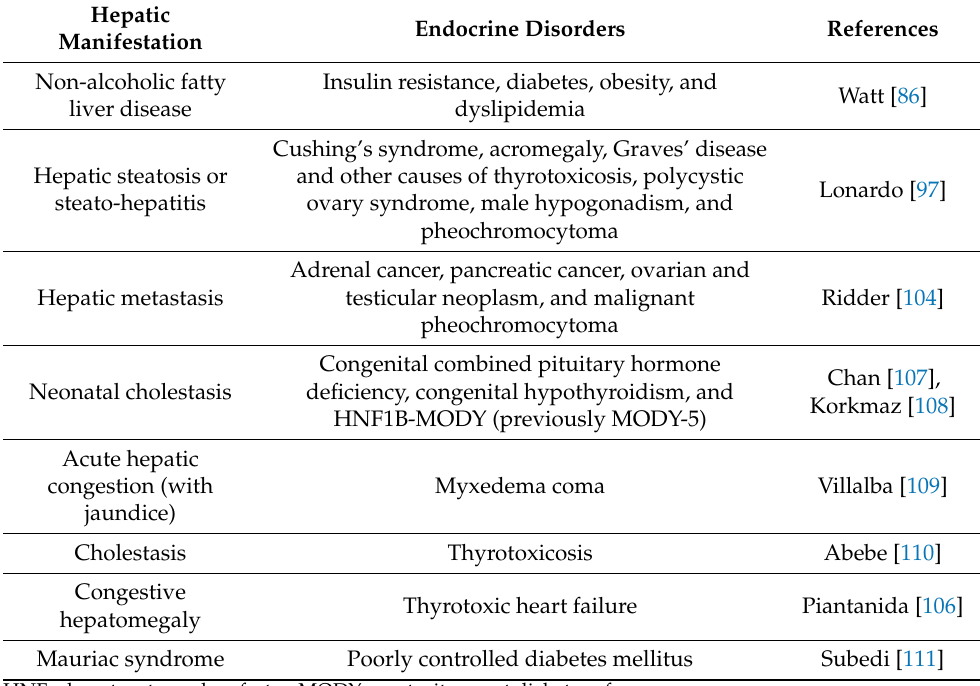
Table 2. Hepatic manifestations of endocrine